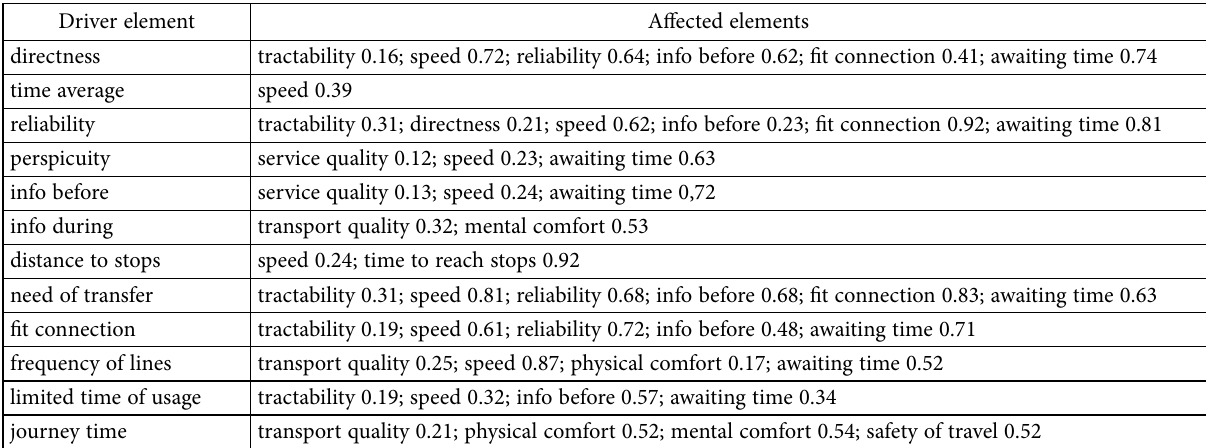
Table 3. Interrelations of the factors regarding the strength of the connection (source: research by author) Driver